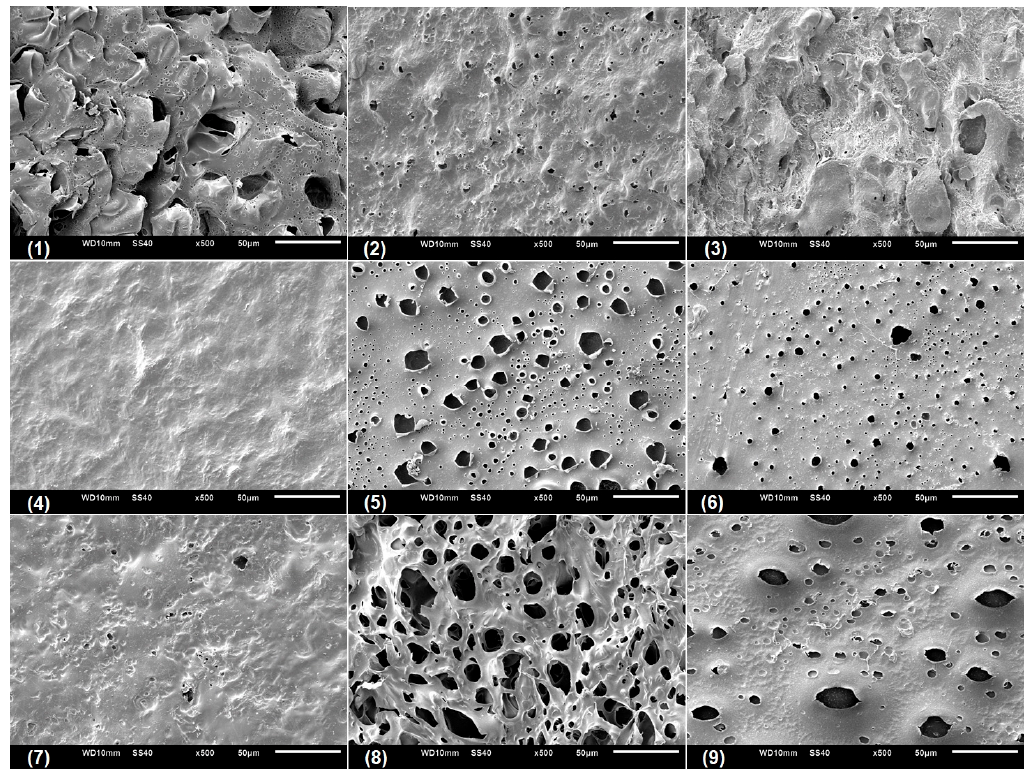
Figure 6. Scanning electron micrographs of CGP/PVA films swollen in ultrapure water.